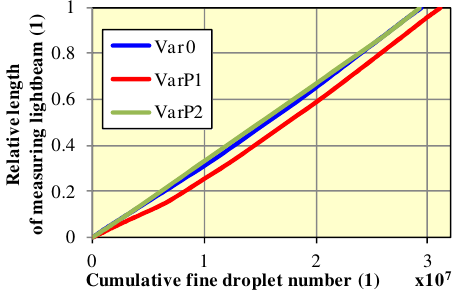
Fig. 8 . Cumulative fine droplet number distributions inside the active cylindrical measuring